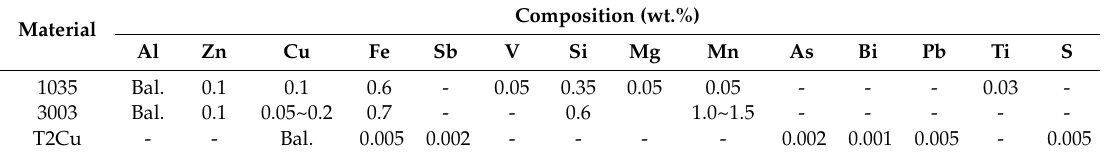
Table 2. Composition of copper plates and aluminum